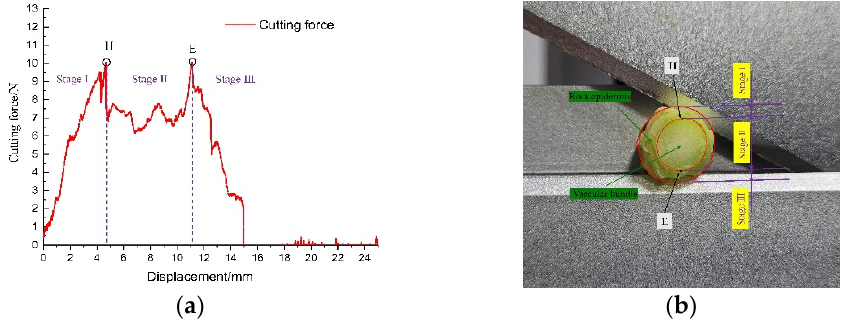
Figure 4. Cutting force–displacement curve. ( a ) Cutting force displacement curve. ( b ) Organizational chart of the root.